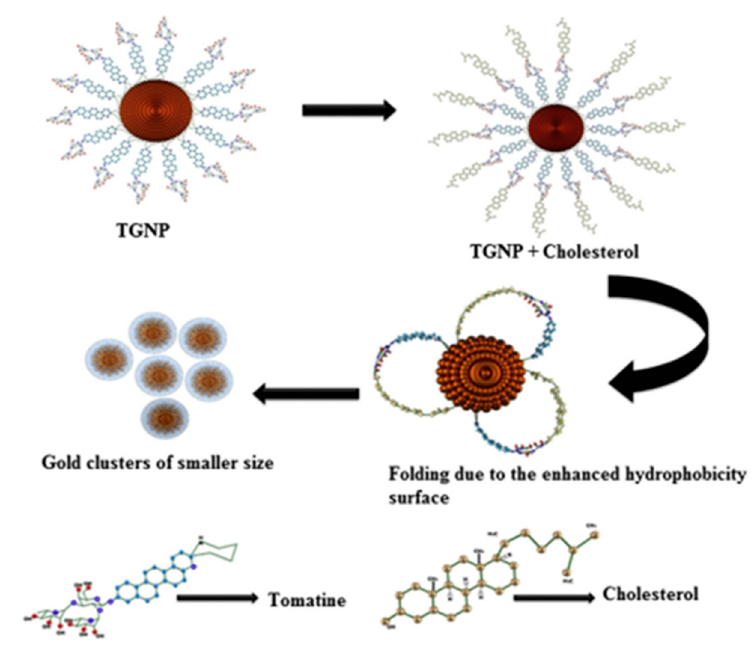
Figure 3. Schematic illustration for the formation of gold nanoparticles by etching of tomatine functionalized gold nanoparticles with cholesterol. Reprinted with permission from Ref.